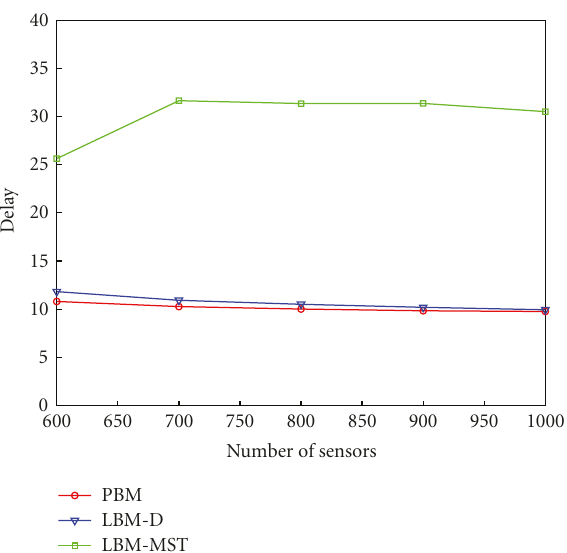
Figure 13: Number of transmissions for destinations grouped together.